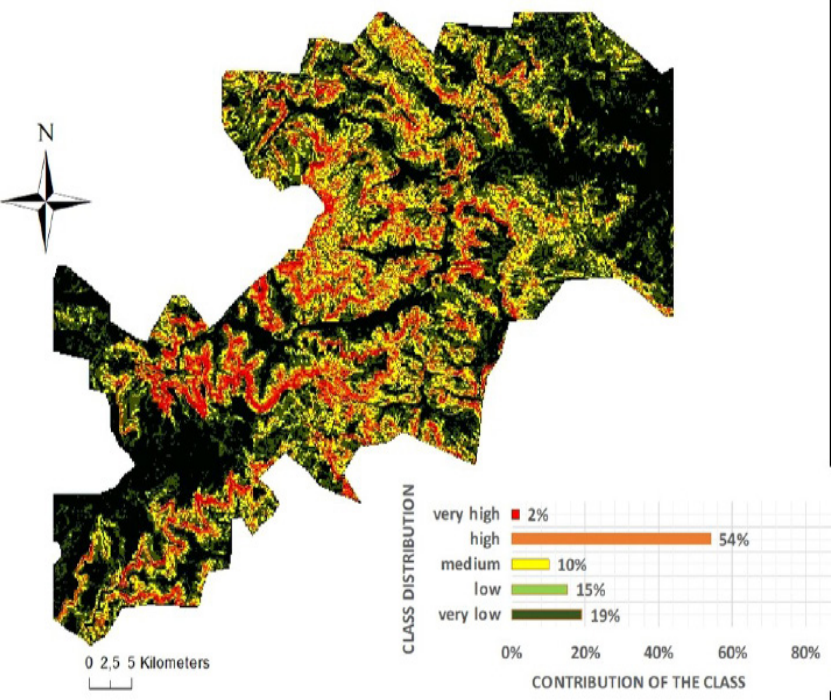
Figure 6. Komati Gorge rela- tive height factor